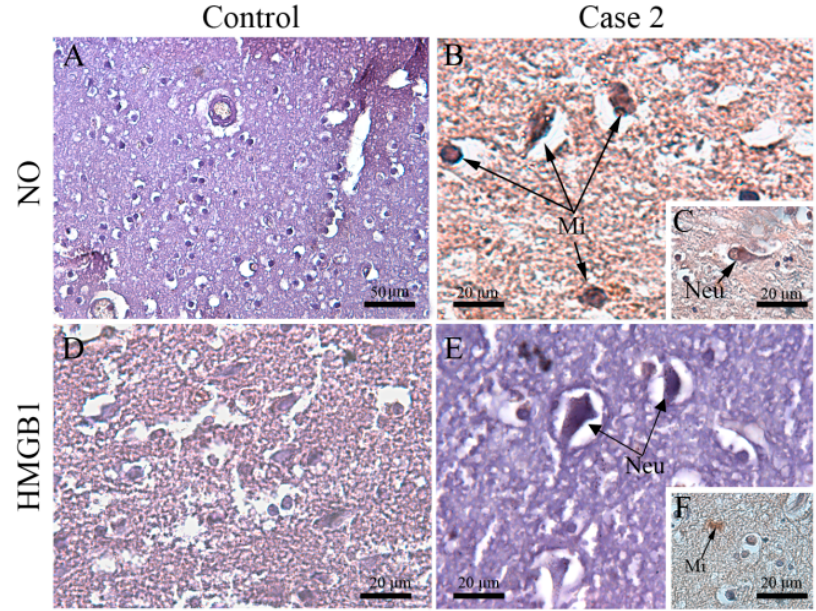
Figure 6. Detection of NO and HMGB1 in brain tissue of fatal cases. ( A – D ) Brain tissue of a non-denguecase; ( B ) Detection of NO in microglial cells ( C ) and neurons, ( E ) Detection of HMGB1 in neurons; ( F ) microglial cells. Neu—Neuron, Mi—Microglia. Viruses 2020 , 12 , 603